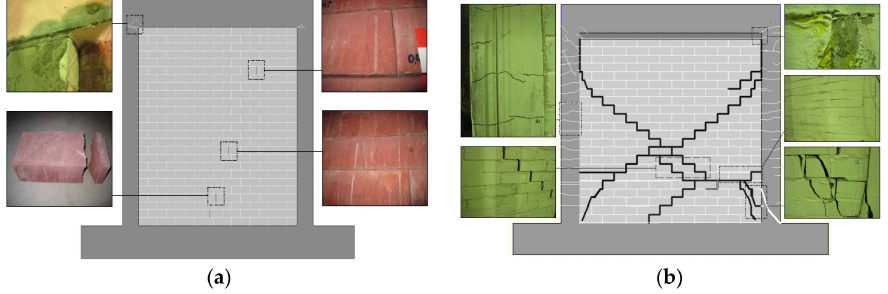
Figure 7. Final crack patterns: ( a ) Reinforcement concrete frame with the dry stacked panel (DSP); ( b ) RC frame with the traditional masonry panel